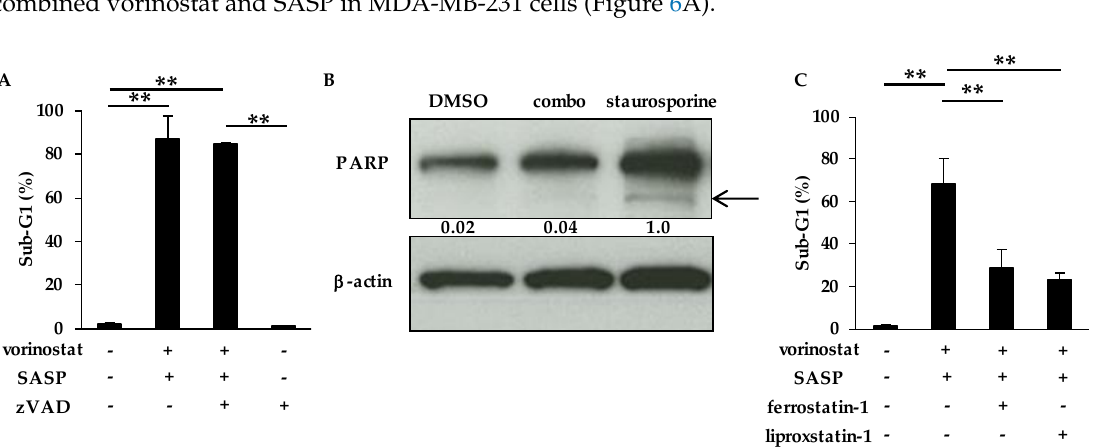
Figure 6. The combinatory treatment of vorinostat with SASP may induce ferroptosis. ( A ) Flow cytometry analysis of cell death induced by cotreatment of vorinostat with salazosulfapyridine (SASP) in the presence or absence of the pan caspase inhibitor zVAD-fmk. MDA-MB-231 cells were treated with the combination of 1.6 µ M vorinostat and 500 µ M SASP with / without 20 µ M zVAD-fmk for 144 h. The percentages of cells in the sub-G1 population were analyzed by flow cytometry. Columns, means ( n = 3); bars, SD. ** p < 0.01. ( B ) The cleavage of PARP (poly (ADP-ribose) polymerase) after combined treatment with vorinostat and SASP. MDA-MB-231 cells were treated with 1.6 µ M vorinostat and 500 µ M SASP for 144 h, and then treated with 1 µ M staurosporine (as a positive control of apoptosis induction) for 6 h. Cleaved PARP was analyzed by Western blotting. The gray value of bands was assessed by imageJ. β -Actin was used as a loading control. ( C ) Flow cytometry analysis of cell death induced by cotreatment of vorinostat with SASP in the presence or absence of the ferroptosis inhibitor ferrostatin-1 or liproxstatin-1. MDA-MB-231 cells were treated with the combination of 1.6 µ M vorinostat and 500 µ M SASP with / without 2 µ M ferrostatin-1 or 0.5 µ M liproxstatin-1 for 144 h. The percentages of cells in the sub-G1 population were analyzed by flow cytometry. Columns, means ( n = 3); bars, SD. ** p < 0.01.